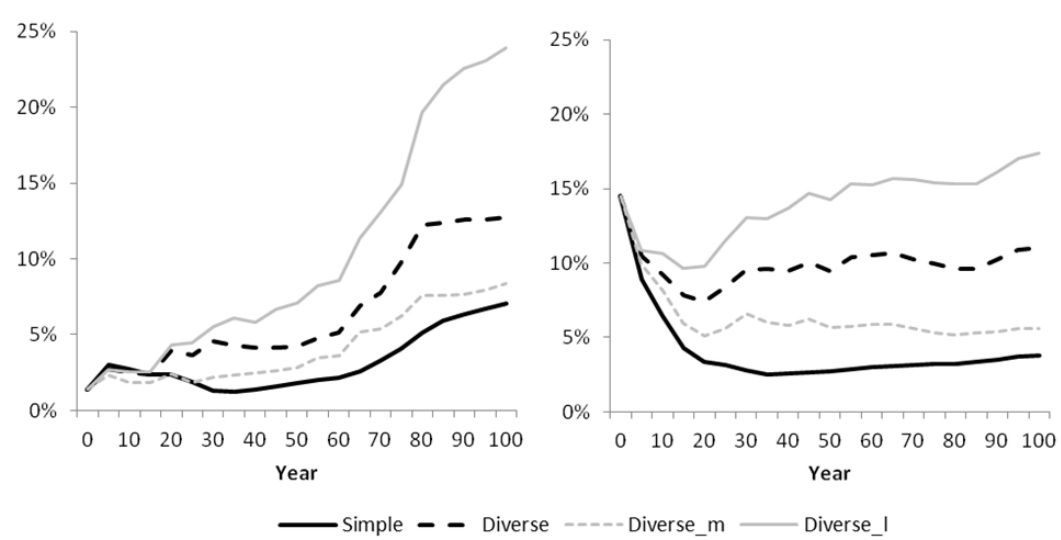
Figure 8. Proportion of old forest in Hässleholm ( left ) and Vilhelmina ( right ), for the Simple and Diverse scenarios, as well as the more intensive (Diverse_m) and less intensive (Diverse_l) variations of the Diverse scenario.